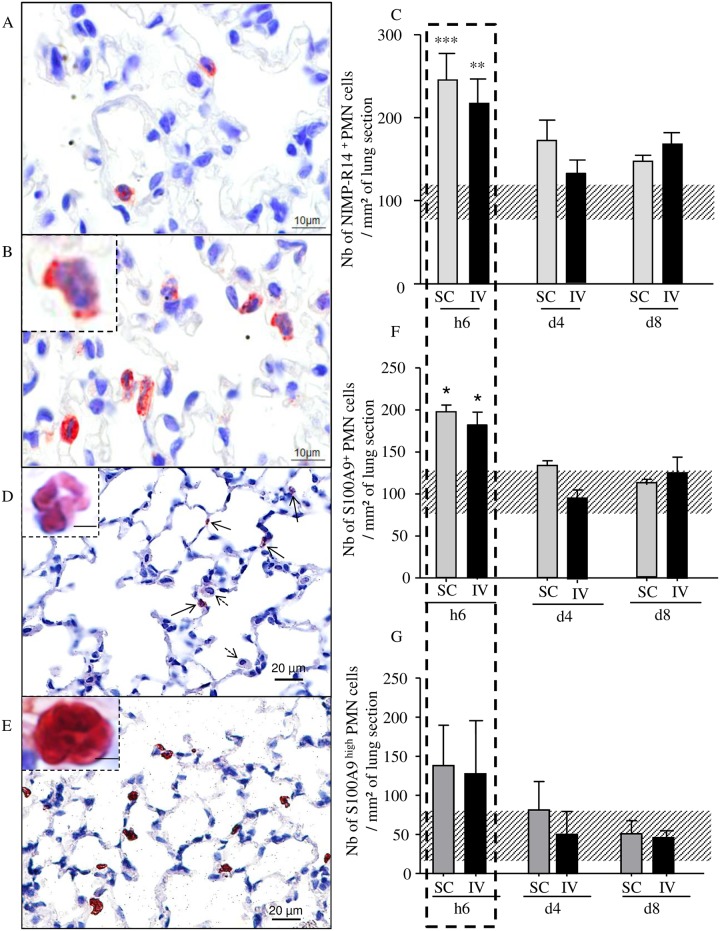
Transient early increase of S100A9 expressing neutrophils in the lung of infected mice.BALB/c mice were inoculated with 40 L3 of L. sigmodontis either subcutaneously (SC) or intravenously (IV). Lung sections were analysed six hours (h6), four days (d4) and 8 days (d8) post inoculation. (A) Ly6G/C (clone NIMPR-R14) immunostaining of lung sections were performed showing a few interstitial neutrophils in naive mice (A) and an increase of neutrophils in h6-infected mice (B). Neutrophils were differentiated from monocytes by their nuclei shapes (B, corner zoom). (C) Number of neutrophils per mm2 on Ly6G/C immunostained sections; bars represent mean ± SEM, n = 4–6 (pool of 3 independent experiments), two-way ANOVA followed by a Bonferonni (**p<0.01, ***p<0.001). Uninfected mice are represented by a dashed horizontal bar. (D-G) S100A9 (clone MU14-2A5) immunostaining of lung sections were performed showing (D) low staining of S100A9 in neutrophils (black arrows). Alveolar macrophages (dotted arrows) are S100A9-. Top left corner: zoom on S100A9low neutrophil, (E) high staining of S100A9 in neutrophils. Top left corner: zoom on S100A9high neutrophil. (F) Total number of S100A9+ neutrophils and (G) number of S100A9high neutrophils per mm2 of lung. Uninfected mice are represented by a dashed horizontal bar. Results are expressed as mean ± SEM; n = 4 mice, 2–3 slides per mouse and 2–4 sections per slide were analyzed.